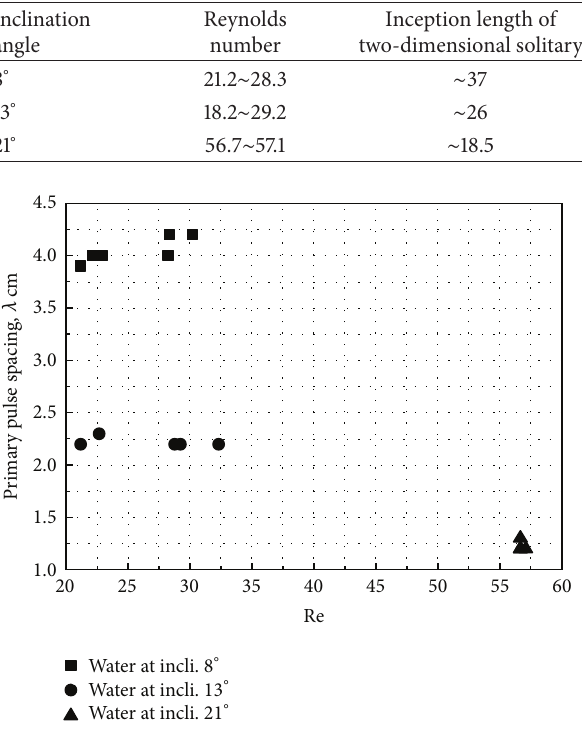
Figure 6: Separation spacing between adjacent solitary